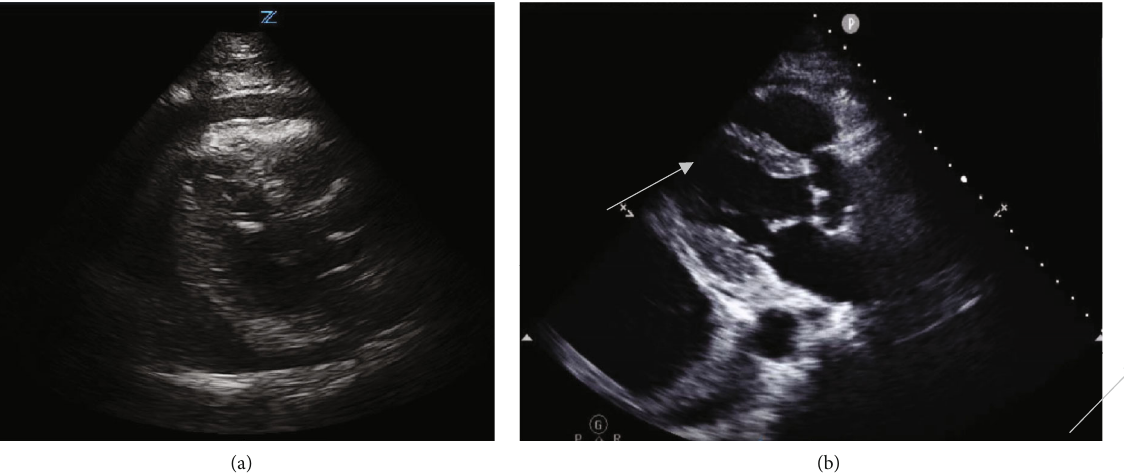
Figure 3: (a) Large pericardial e ff usion prior to cardiac arrest. (b) Post-CPR resolution of pericardial e ff usion and large left pleural e ff